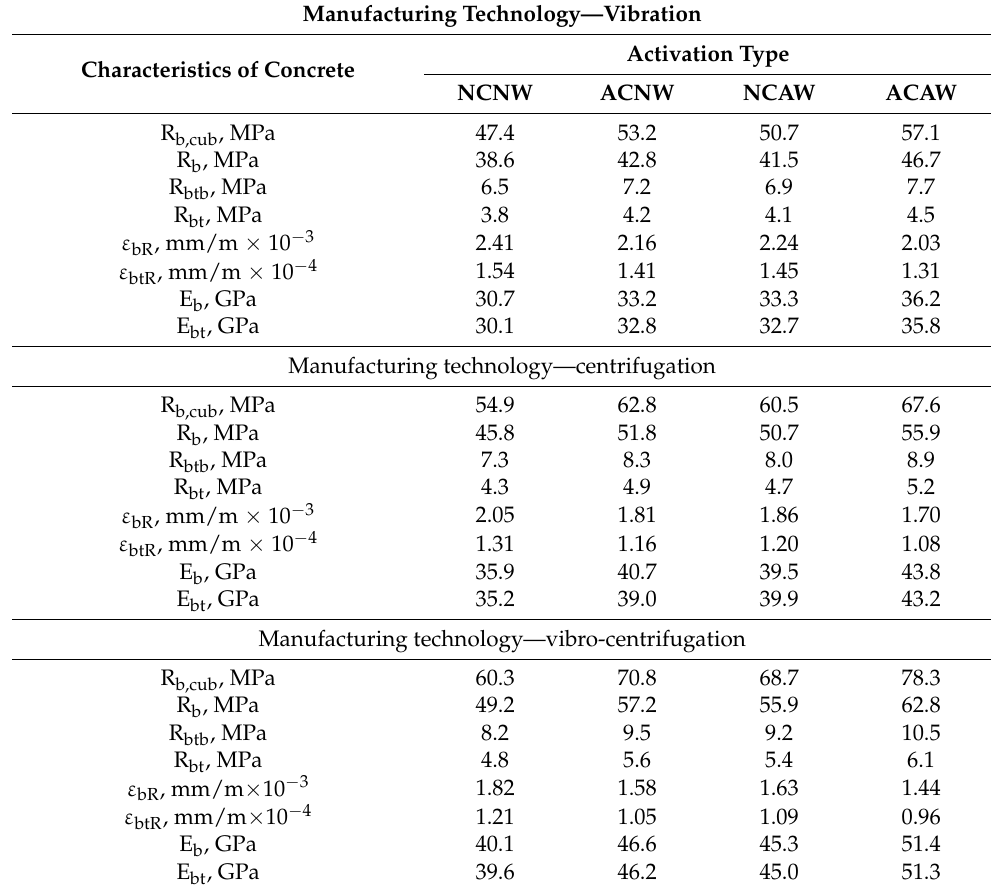
Table 7. Results of experimental studies of the strength and deformation characteristics of concrete with various types of activation and manufacturing technology.